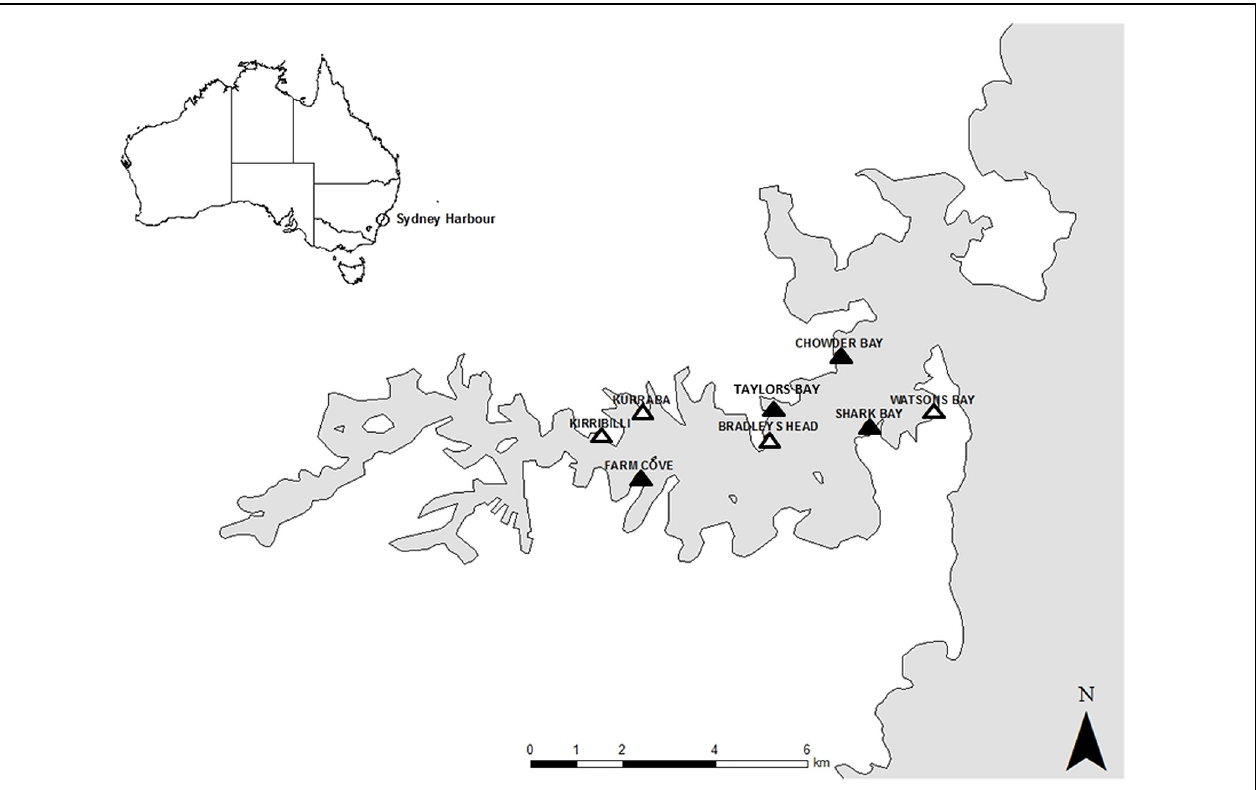
FIGURE 1 | Map of Sydney Harbour with the studied locations. Natural rocky shores were studied at Taylors Bay, Chowder Bay, Farm Cove, and Shark Bay. Seawalls were studied at Bradleys Head, Kirribilli, Kurraba, and Watsons Bay.